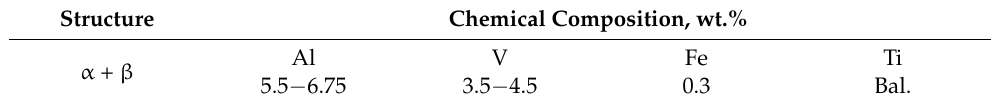
Table 1. Structure and chemical composition of Ti6Al4V alloy. Structure